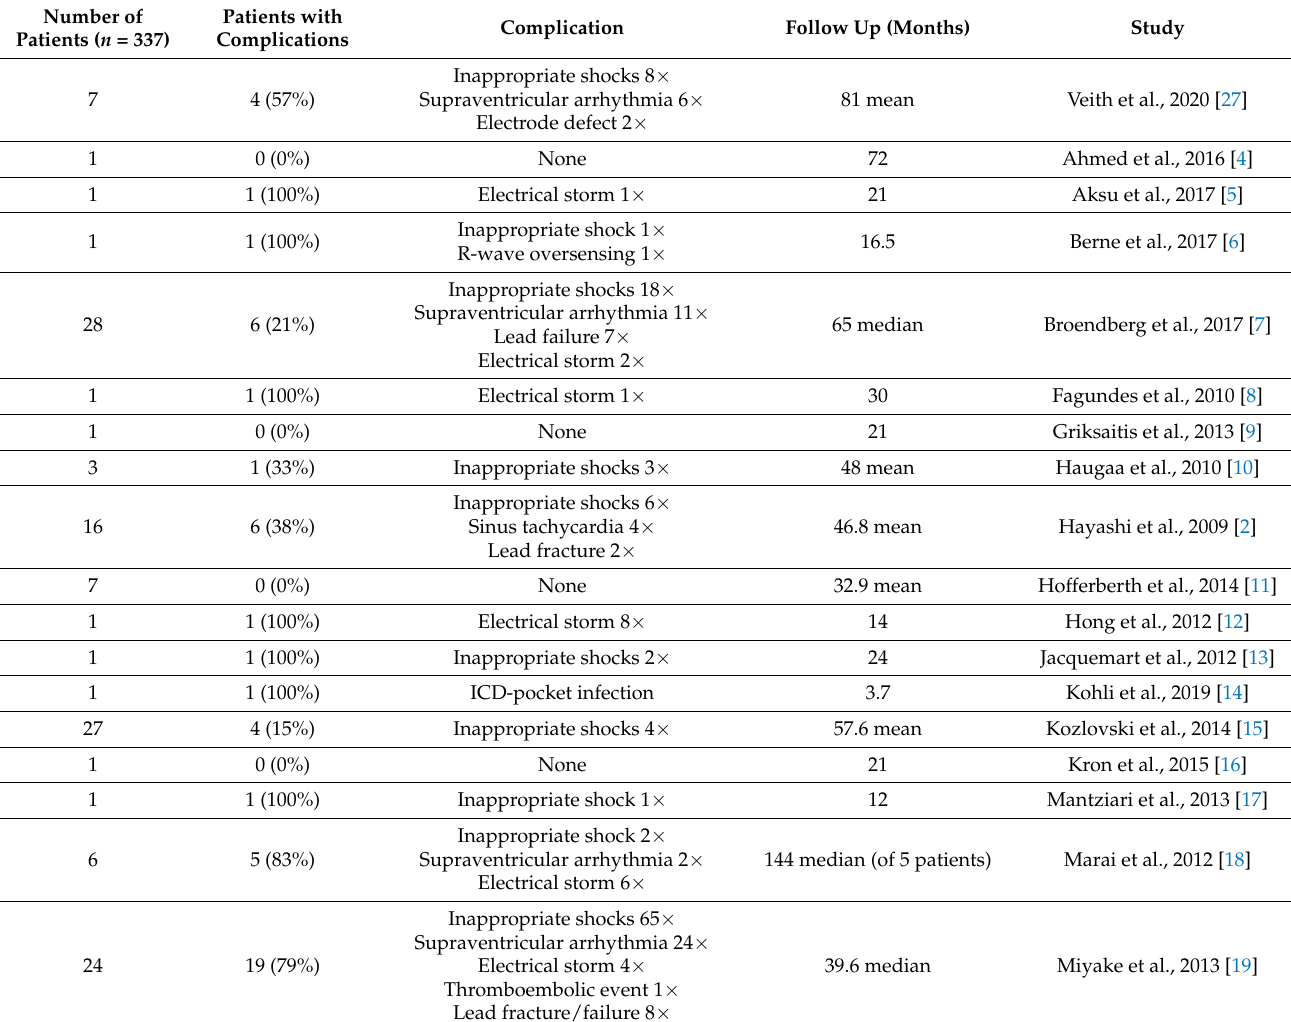
Table 2. Detailed description documenting ICD